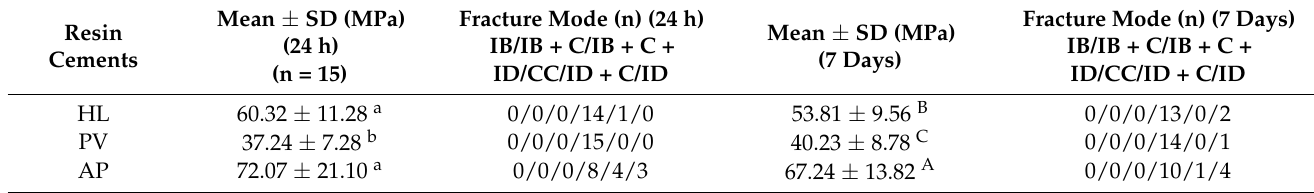
Table 2. Mean ± SD of µ TBS and fracture modes of resin